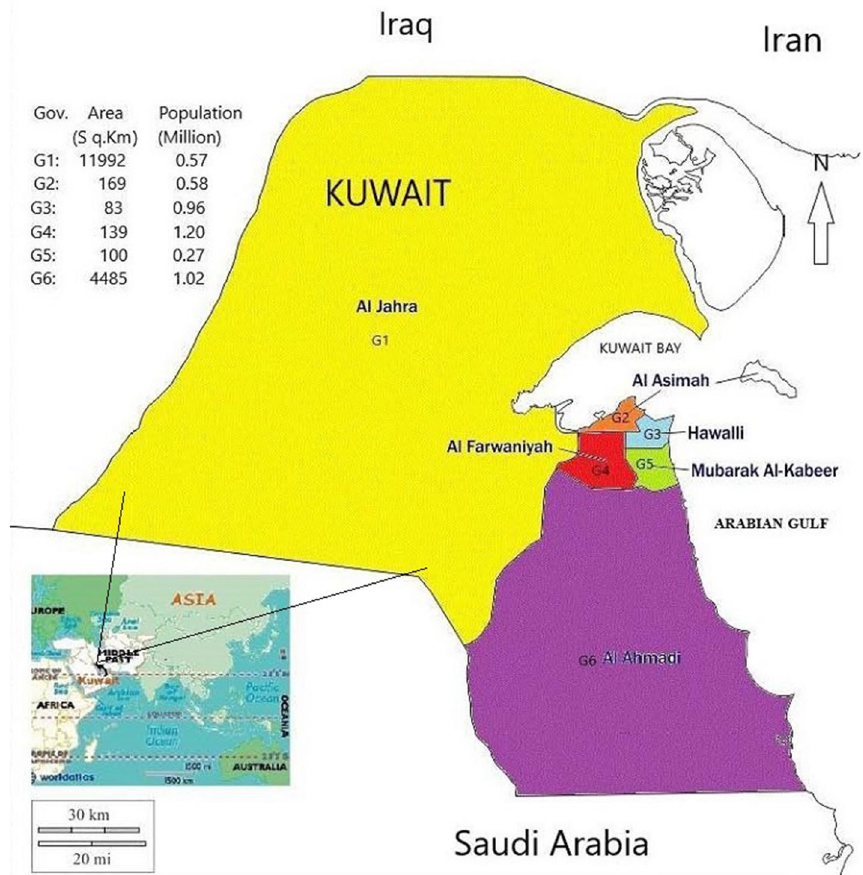
Figure 1. Six Kuwait Governorates selected for sampling. G1–G6: Governorates: Al-Jahra, Al-Asimah, Al-Hawalli, Farwaniya, Mubarek Al-Kabeer, Al-Ahmedi. This map available publicly is generated using MS-Paint